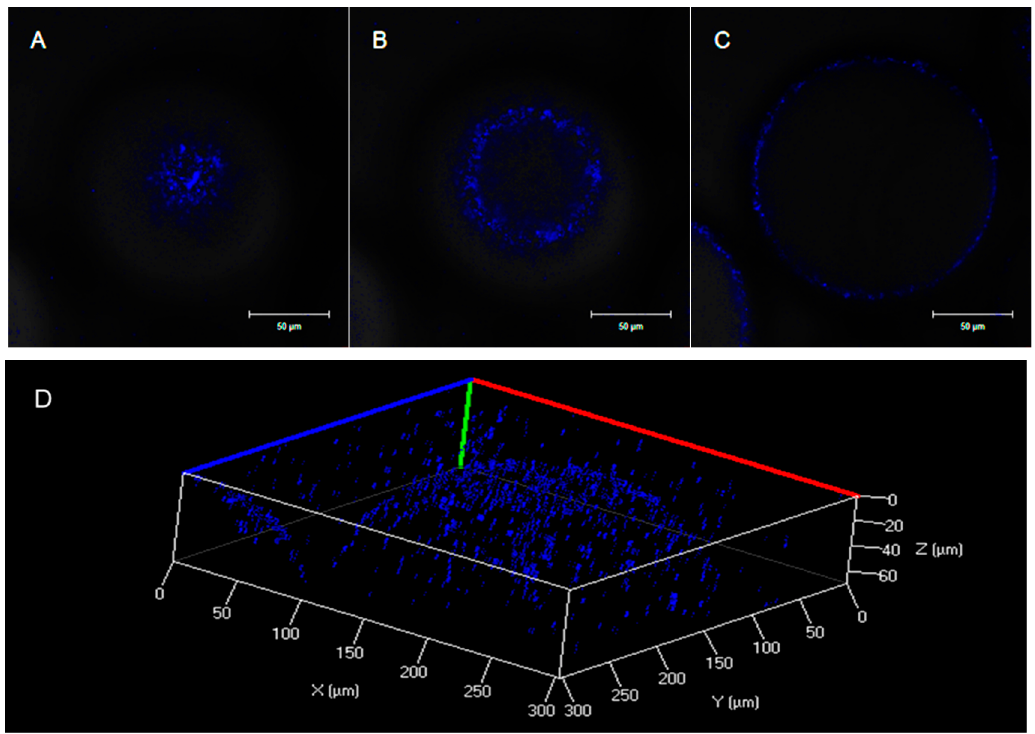
Figure 3. Confocal images of emulsion stabilized by D. tsuruhatensis LW26 stained with fluorescent 4, 6-diamidino-2-phenyl-indole (DAPI). Bacterial cells mainly localized at the interface of silicone oil droplets in the blue fluorescent field at z = ( A ) 5, ( B ) 15, and ( C ) 45 μ m. Scale bars represent 50 μ m. ( D ) Microbial distribution in the 3D system.